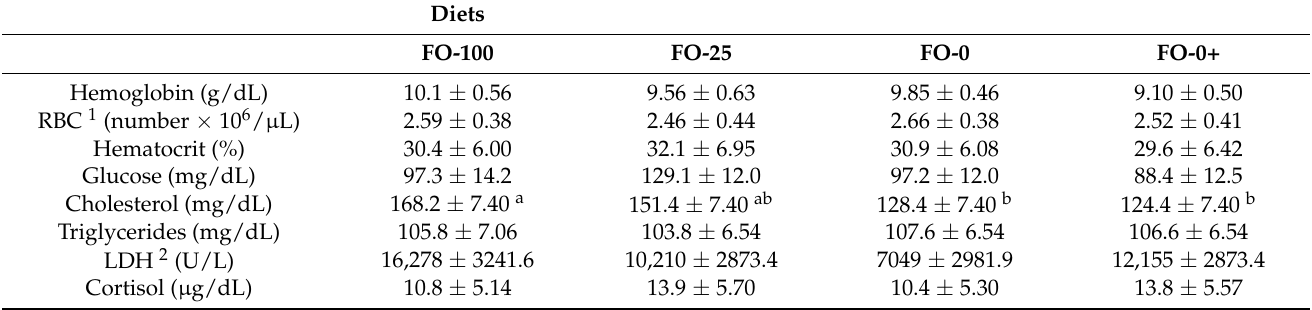
Table 4. Hematological parameters of Mediterranean yellowtail ( Seriola dumerili ) fed the experimental diets for 109 days. Diets FO-100 FO-25 FO-0